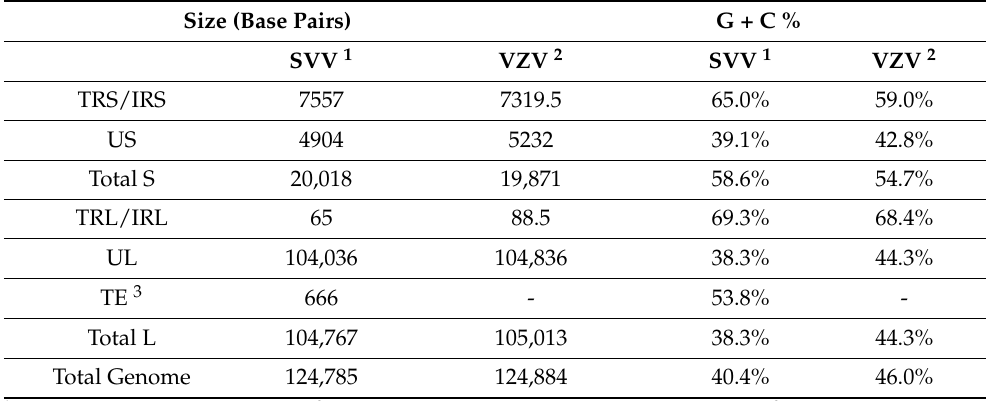
Figure 1. The SVV and VZV genomes consist of a short (S) component linked to a long (L) component. The S includes a unique sequence (US) flanked by internal and terminal inverted repeats (IRS, TRS). The L component includes a unique long (UL) segment bracketed by internal and terminal repeats (IRL, TRL). The SVV genome has an invertible terminal element (TE) that does not exist in VZV DNA. Table 1. Comparison of the SVV and VZV genomes.